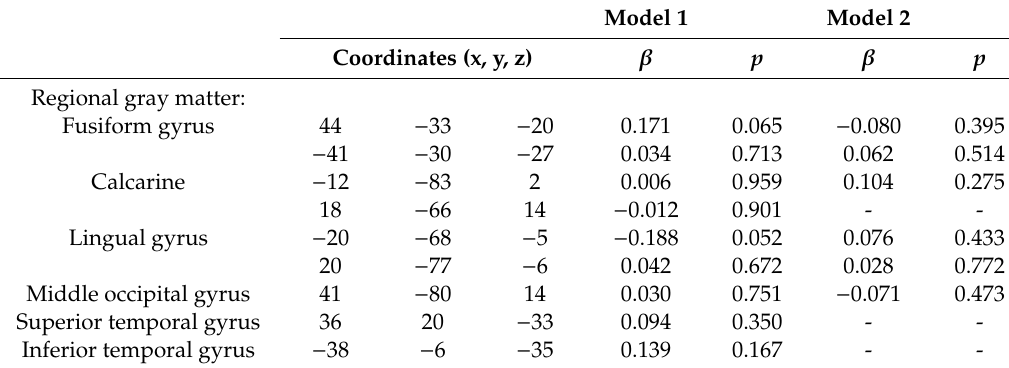
Figure 3. Brain regions showing greater gray matter volume in metabolically healthy overweight / obesity children ( n = 52) compared to those metabolically unhealthy overweight / obesity ( n = 45). The analyses were adjusted for sex, peak height velocity (years), parental education level (none / one / both of them), and body mass index (kg / m 2 ) (Panel A ), and additionally for cardiorespiratory fitness (VO 2 max) (Panel B ). The results were thresholded using AlphaSim at p < 0.001 with k = 60 (Model 1) and k = 54 (Model 2) voxels, and they surpassed Hayasaka correction (see Table 2). The color bar represents the associations (orange color changed to yellow as the association is getting higher, i.e., a greater intensity in the orange color indicated a lower association). The images are displayed in neurological convention; thus, the right hemisphere corresponds to the right side in coronal displays. The sagittal planes show the left hemisphere (top of the figure) and right hemisphere (bottom of the figure). Table 3. Associations between regional gray matter volume and academic achievement in overweight and obese